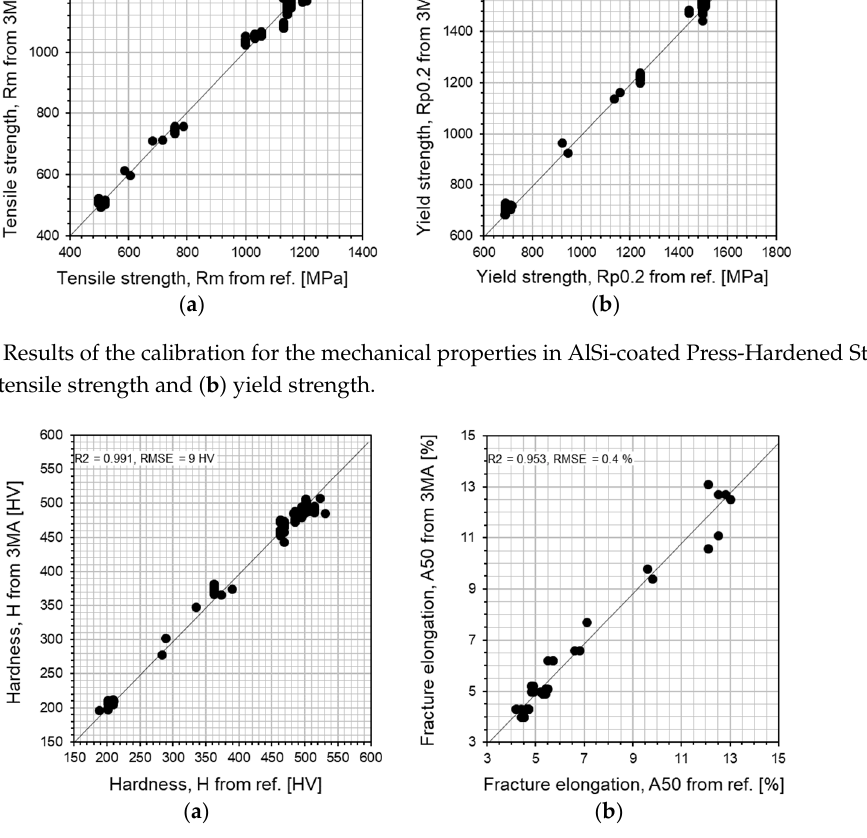
Figure 19. Results of the calibration for mechanical properties in AlSi ‐ coated PHS: ( a ) hardness and ( b ) fracture.